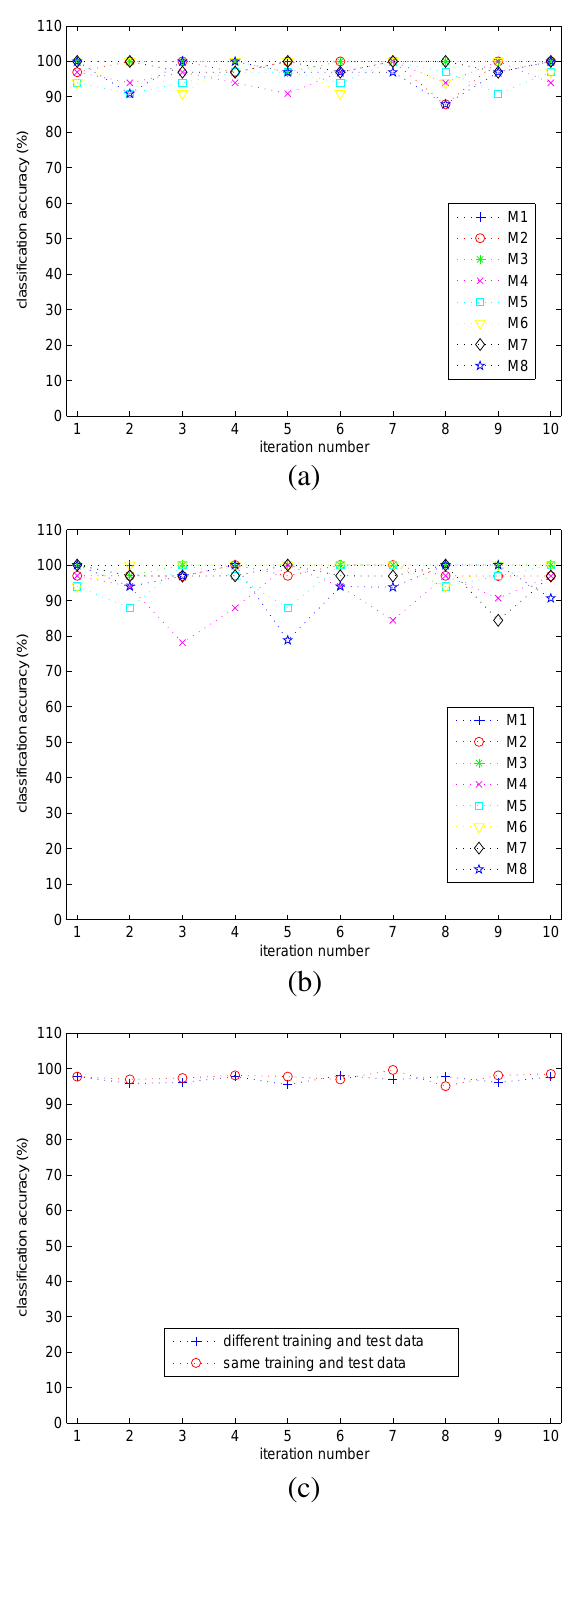
Figure 9. Classification accuracy for each motion type versus the iteration number when (a) the same and (b) different training and test data sets are used in each iteration. (c) The average classification accuracy over all motion